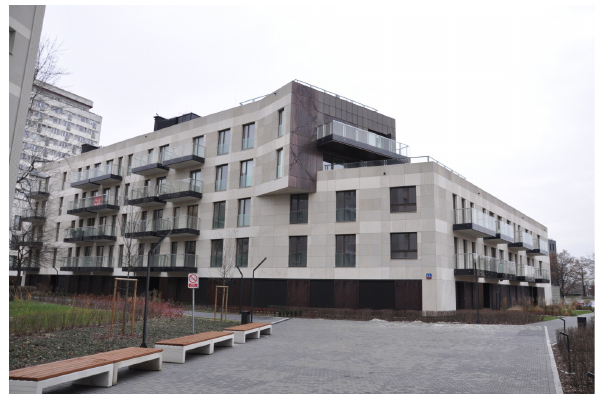
Figure 1: General view of the development (building